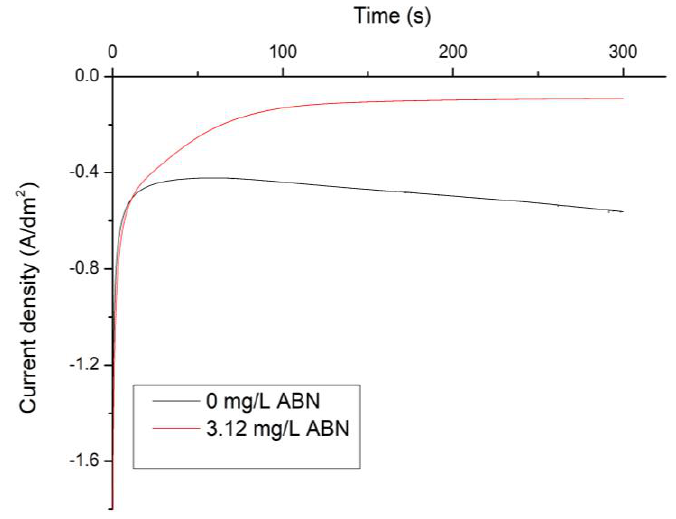
Figure 5. Current density transients in chloride based electrolyte at − 0.8 V. The ABN inhibition process reaches equilibrium after 100 s of deposition.